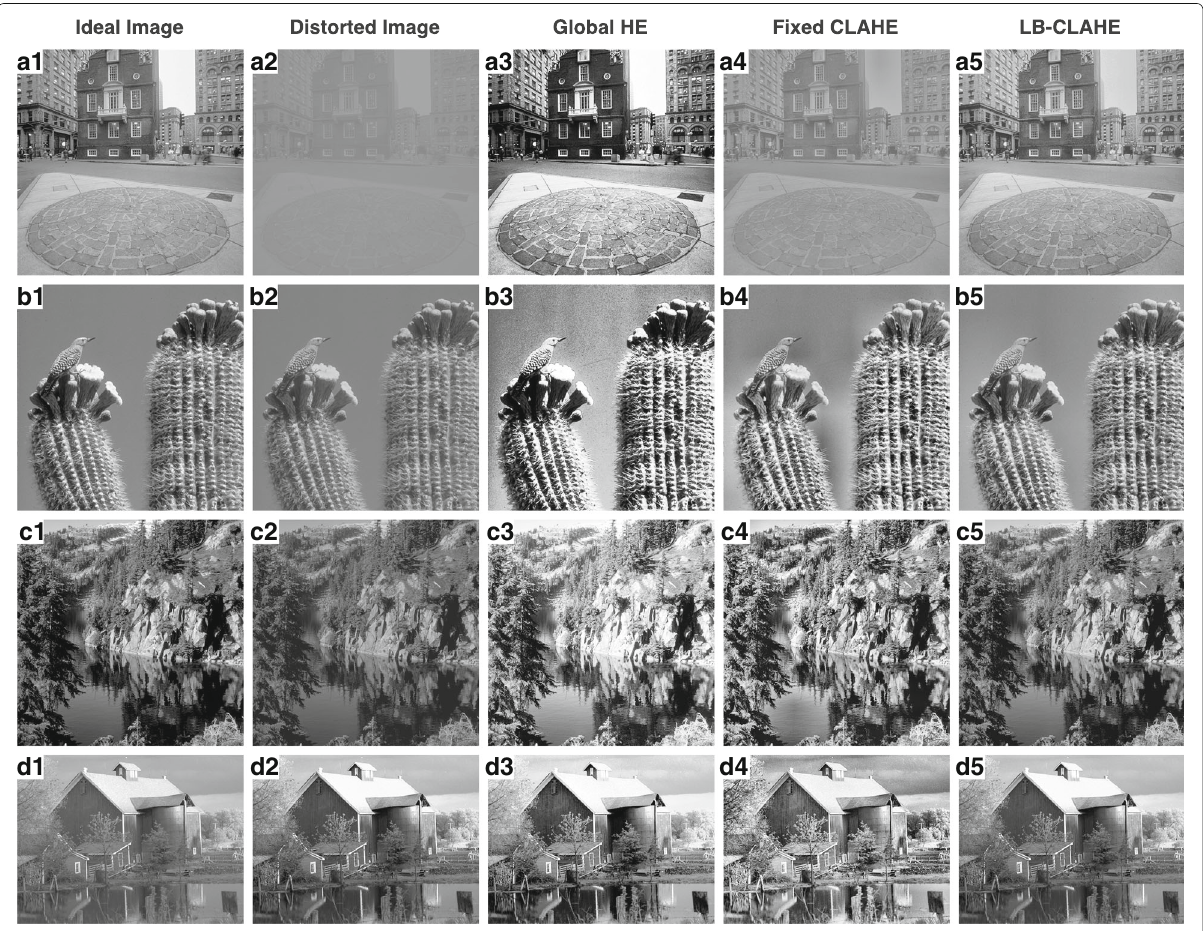
Fig. 9 LB-CLAHE’s high performance according to the IQA techniques in different contrast scenarios. Heavy decrease in contrast ( A ), mean decrease in contrast ( B ), slight decrease in contrast ( C ), increase in contrast ( D ). Ideal image ( 1 ), distorted image ( 2 ), global HE ( 3 ), fixed CLAHE with CL = 0.01 and NT = [8,8] ( 4 ), proposed LB-CLAHE ( 5